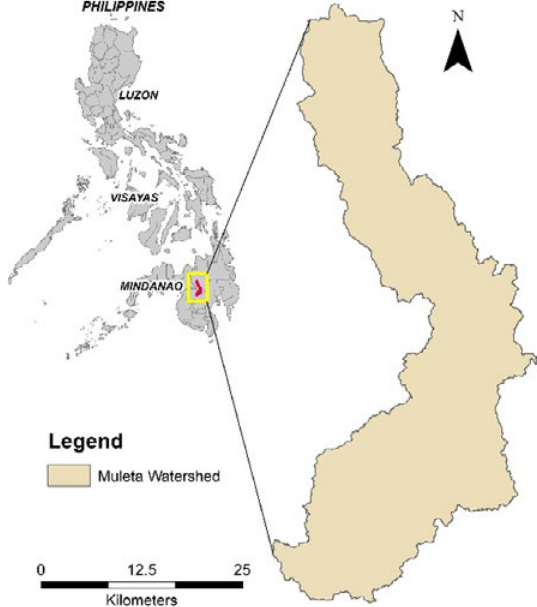
Fig. 1. Geographic location of the study area in Muleta watershed, Bukidnon and North Cotabato, Mindanao, Philippines